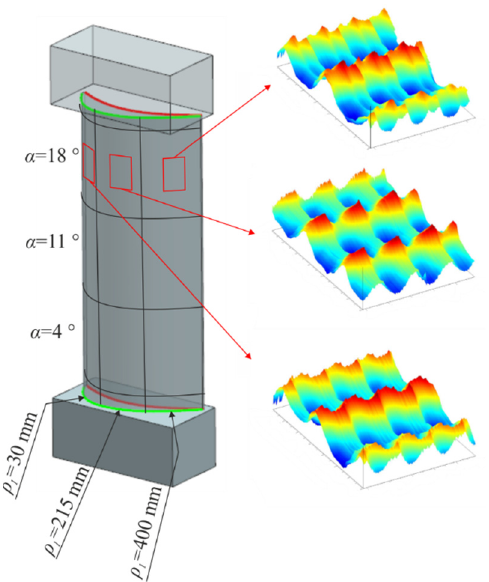
Figure 26. Topography of the convex surface when changing the curvature radius for the lead angle α = 18°.